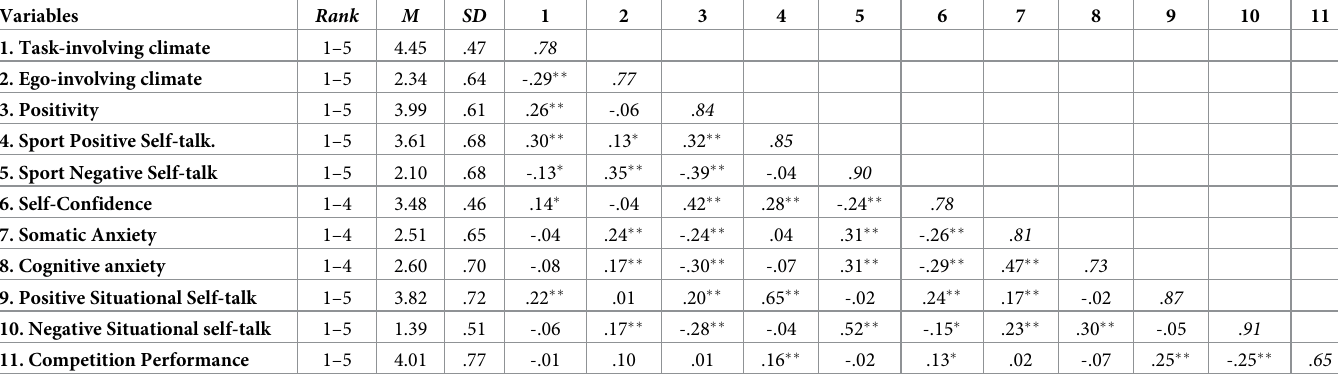
Table 1. Means, standard deviations, bivariate correlations, and reliability analysis of the variables.